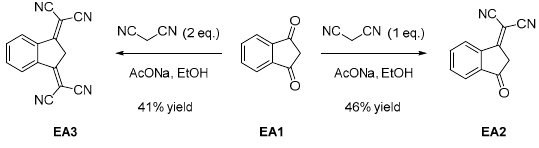
Figure 1. Electron acceptors EA1–EA3 .